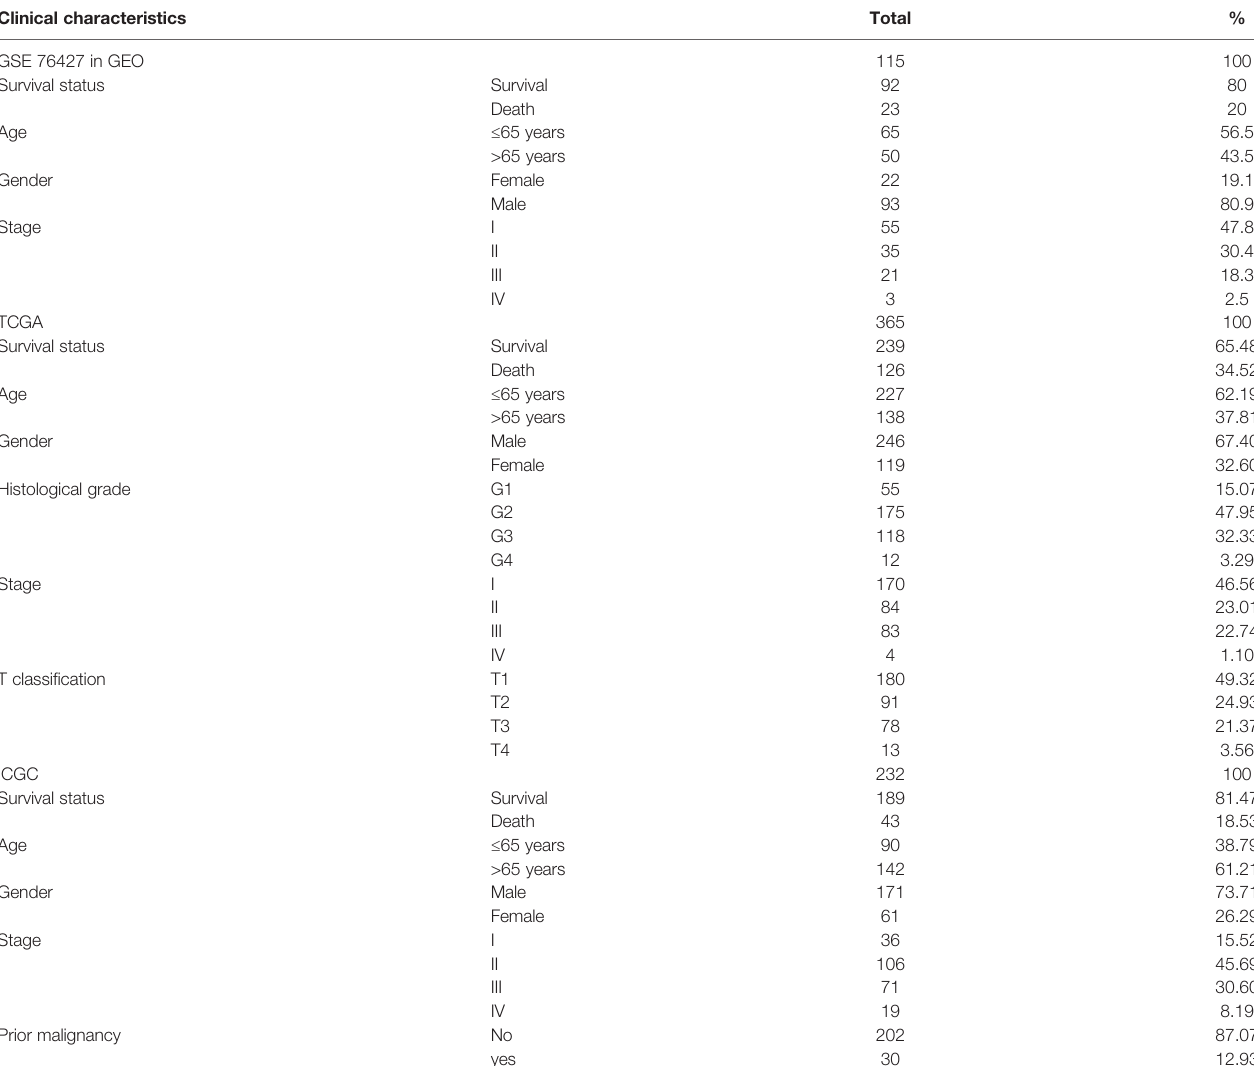
TABLE 1 | Patients' information in the GEO, TCGA, and ICGC cohorts. Clinical